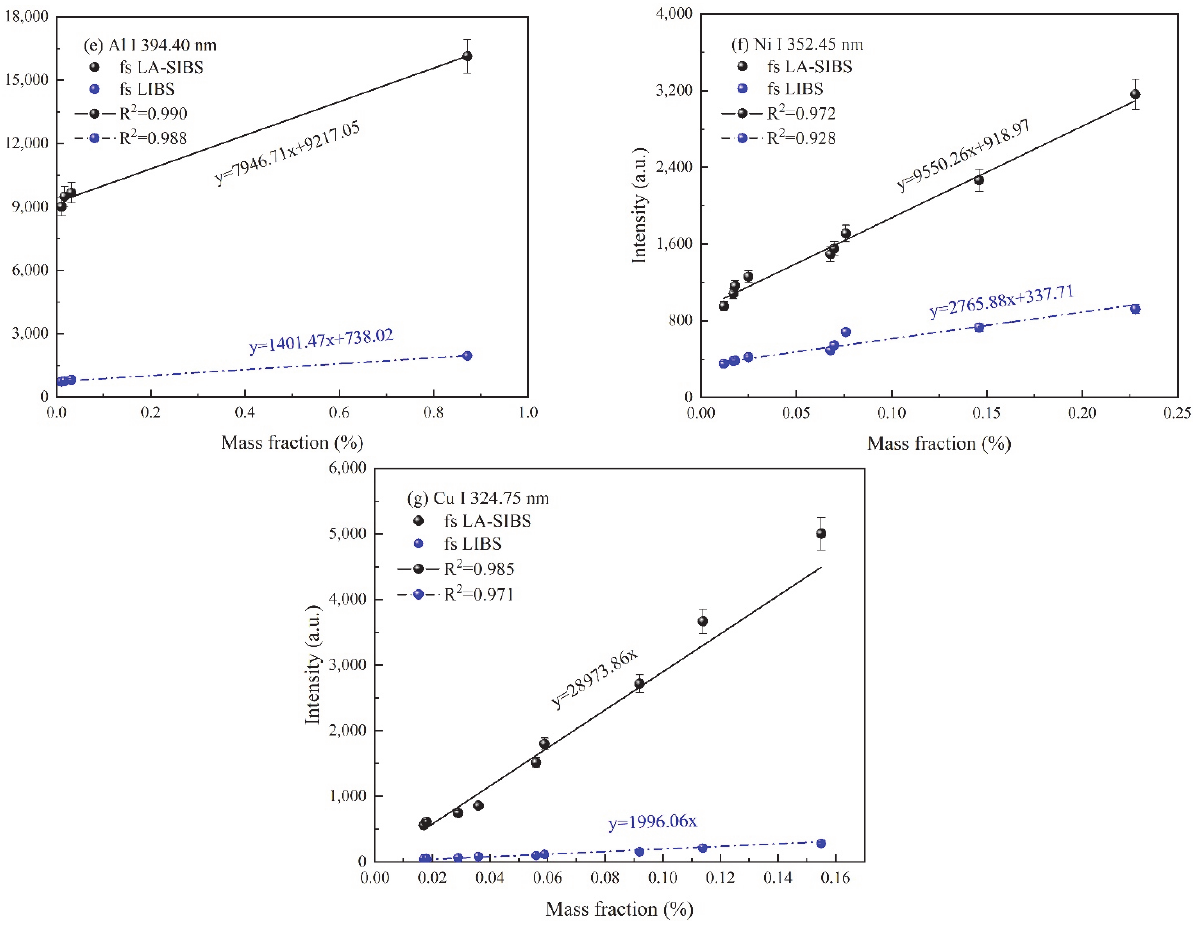
Figure 6. Calibration curves of vanadium, molybdenum, chromium, manganese, aluminum, nickel, and copper in steel alloy standard samples obtained in fs LA-SIBS and fs LIBS. ( a ) V I 437.92 nm, ( b ) Mo I 379.82 nm, ( c ) Cr I 425.43 nm, ( d ) Mn I 403.08 nm, ( e ) I Al I 394.40 nm, ( f ) Ni I 352.45 nm, and ( g ) Cu I 324.75 nm.